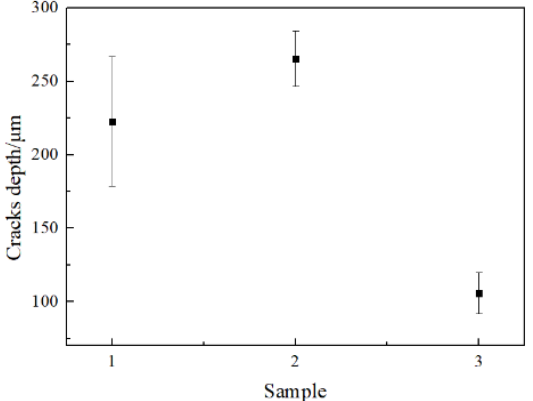
Figure 8. Comparison of the arithmetic mean depth of cracks after ELM-like thermal loading; 1, 2, and 3 represent the as-sintered sample with 330 MW/m 2 thermal load, the as-sintered sample with 440 MW/m 2 thermal load, and the as-forged sample with 440 MW/m 2 thermal